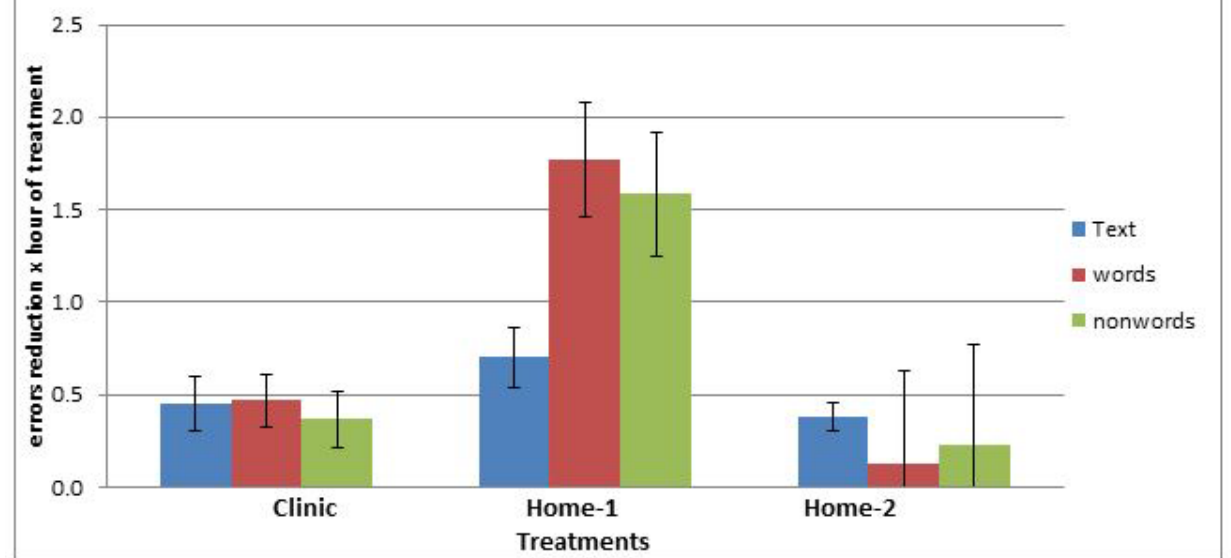
For accuracy, treatment Home-1 obtained the best outcomes in all three types of reading tasks. For text accuracy, the difference with treatment Clinic is d =0.40; II=16%, whereas the difference with Home-2 is d =0.77; II=28%. For word accuracy the difference of treatment Home-1 with respect to the two other treatments equals to d =1.0; II=34%, whereas the difference for nonword accuracy with respect to the two other treatments equals to d = 0.80; II=29%. To summarize, treatment Home-1 obtained the best results x hour of intervention in both fluency and accuracy in all three reading measures, followed by treatment